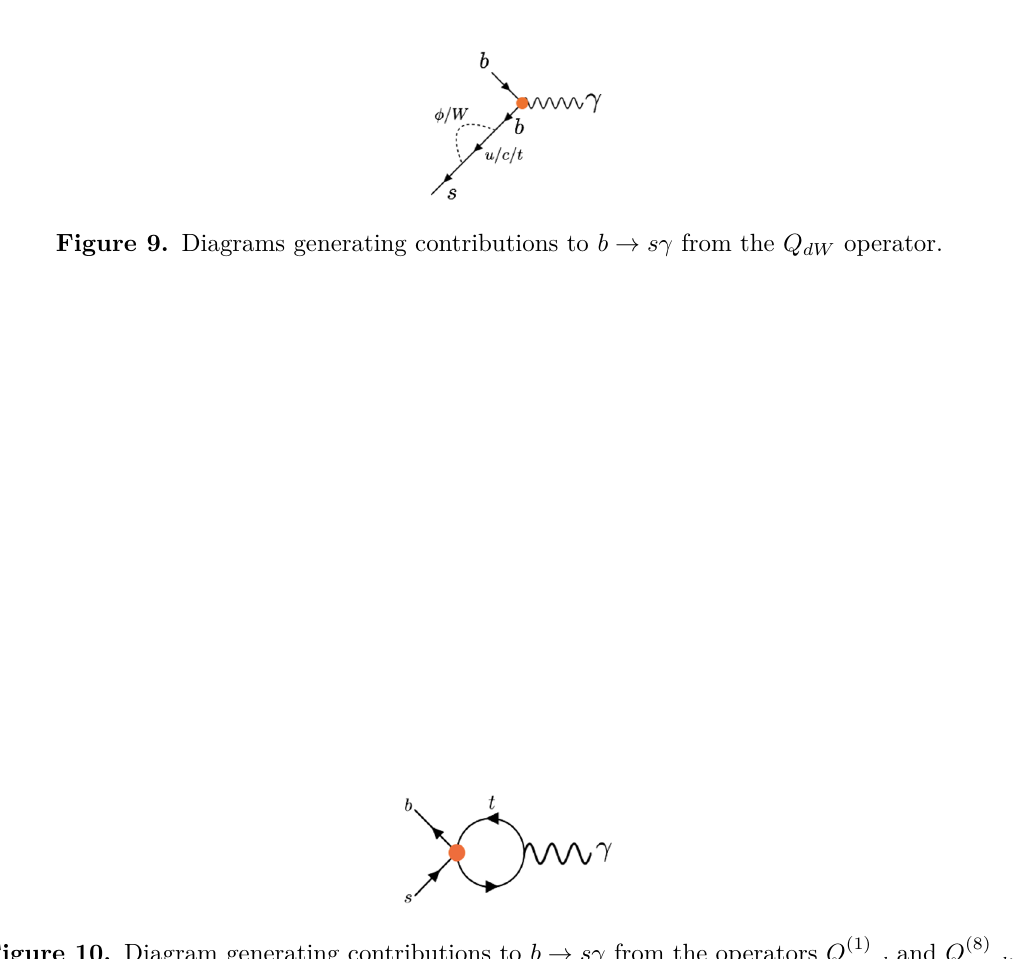
Figure 10. Diagram generating contributions to b → sγ from the operators Q (1)